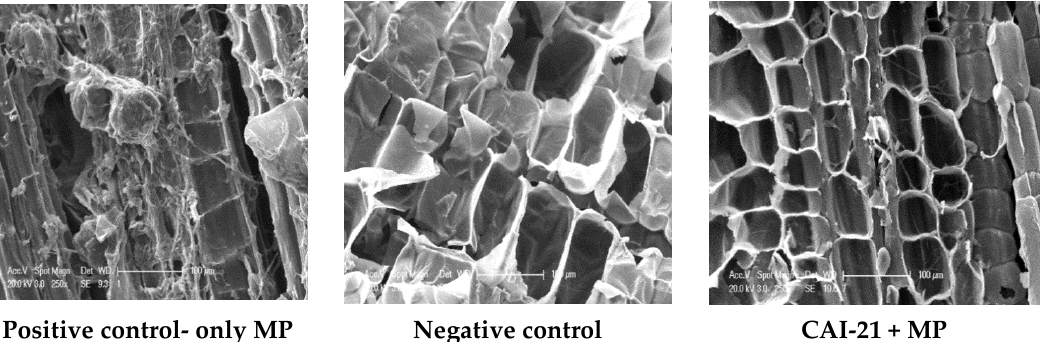
Figure 5. SEM photographs showing morphological changes in the stalks of sorghum of positive control (only MP), negative control, and S. albus CAI-21 + MP-treated plants. MP, M. phaseolina .